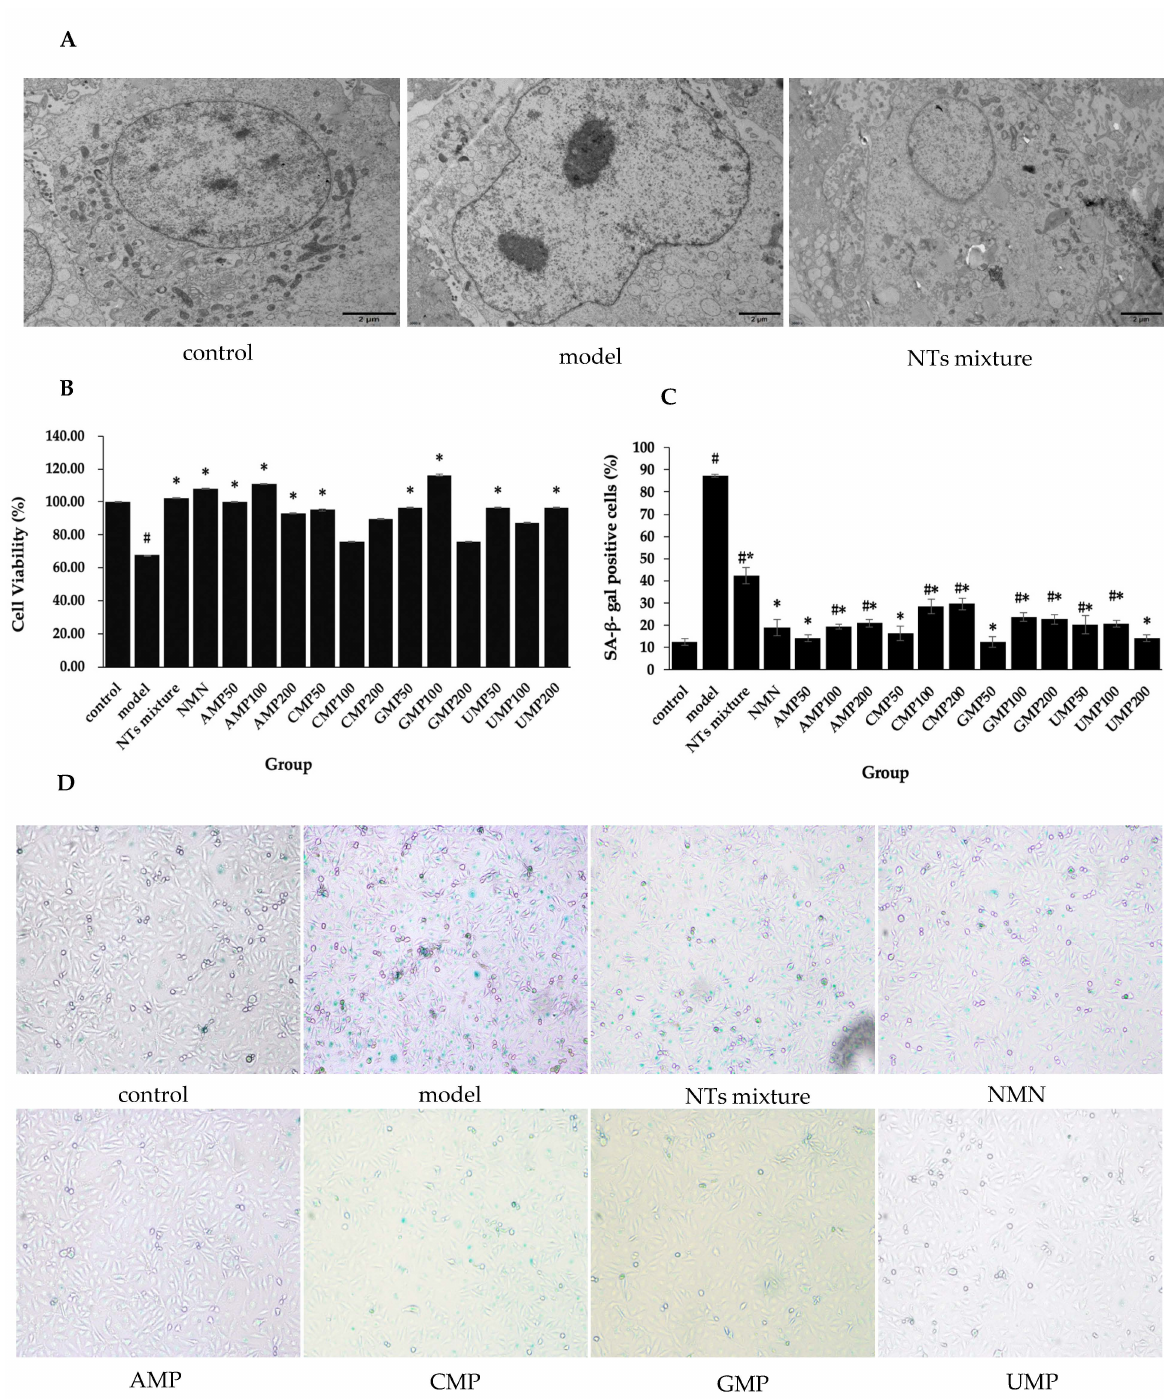
Figure 1. Effect of NTs on senescent HUVECs morphological changes, cell viability, and SA- β -gal activity. ( A ) Effect of NTs on senescent HUVECs morphological changes using transmission electron microscopy (3000 × ). ( B ) Cell viability evaluation of NTs using the CCK-8 assay ( n = 5 per group). ( C ) Statistical quantification of SA- β -gal-positive cells ( n = 3 per group). ( D ) Representative image of SA- β -gal staining. Values represented the mean ± S.D. # p < 0.05 versus control group, * p < 0.05 versus model